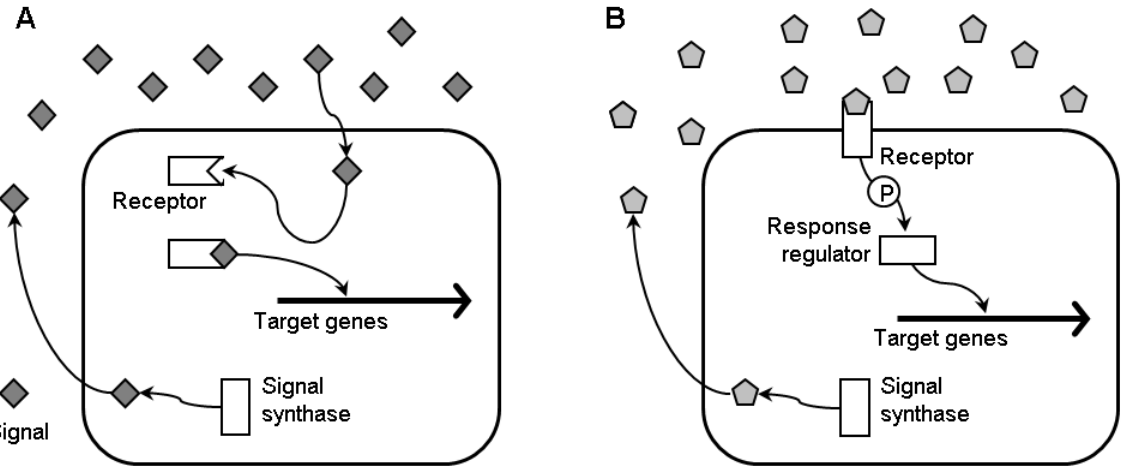
Figure 1. General scheme of a quorum sensing system. The signal synthase enzyme (a homolog of V. fischeri LuxI in the case of AHL quorum sensing) produces signal molecules, which reach the extracellular environment either via diffusion or transport. At a critical signal molecule concentration, the signal binds to the receptor, which can be located in the cytoplasm (a homolog of V. fischeri LuxR in the case of AHL quorum sensing) (A) or at the cell surface (B). If the receptor is located in the cytoplasm, the signal–receptor complex activates or inactivates transcription of the target genes. If the receptor is located at the cell surface, target gene transcription is modulated through a phosphorylation/dephosphorylation signal transduction cascade with a transcriptional regulator at the end (e.g., a homolog of V. harveyi LuxR Vh ). P denotes phosphotransfer.